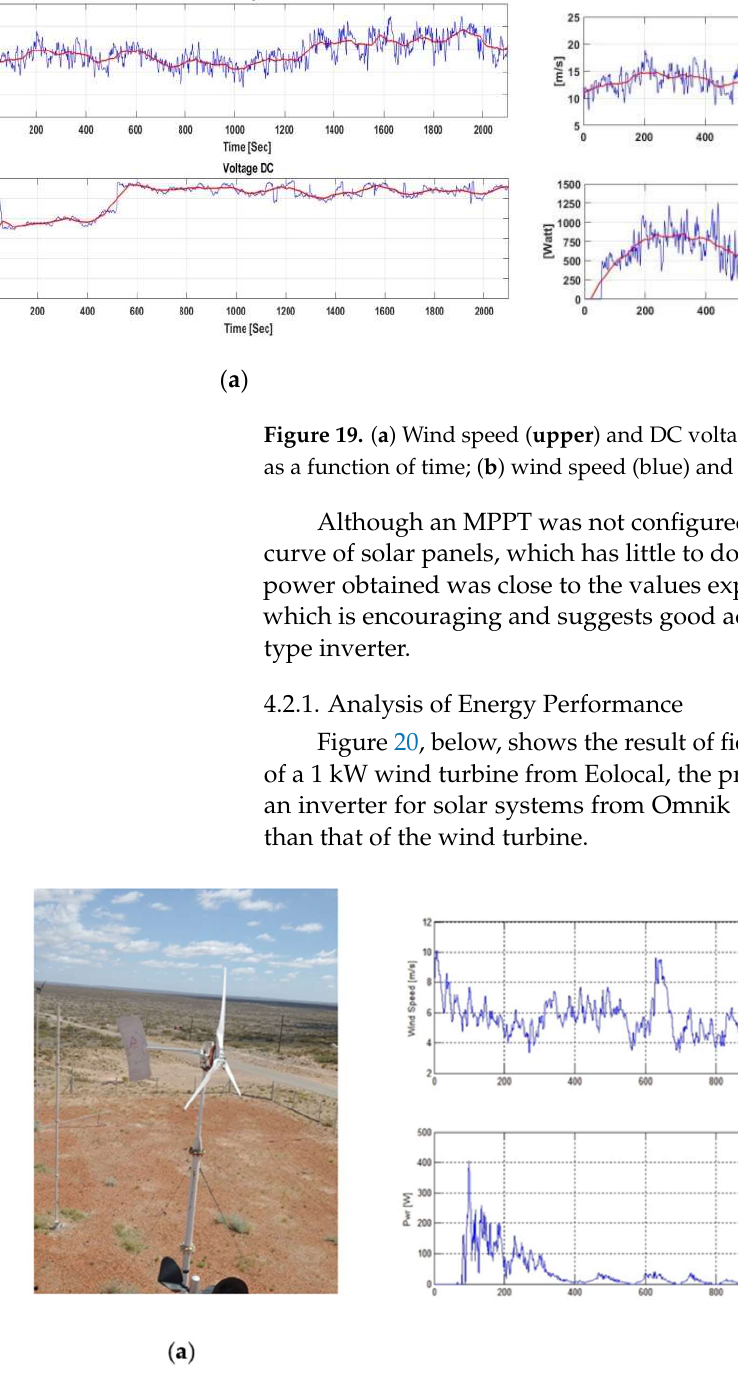
Figure 20. ( a ) Field test layout; ( b ) wind speed ( upper ) and DC power output ( lower ) for perfor- mance assessment.